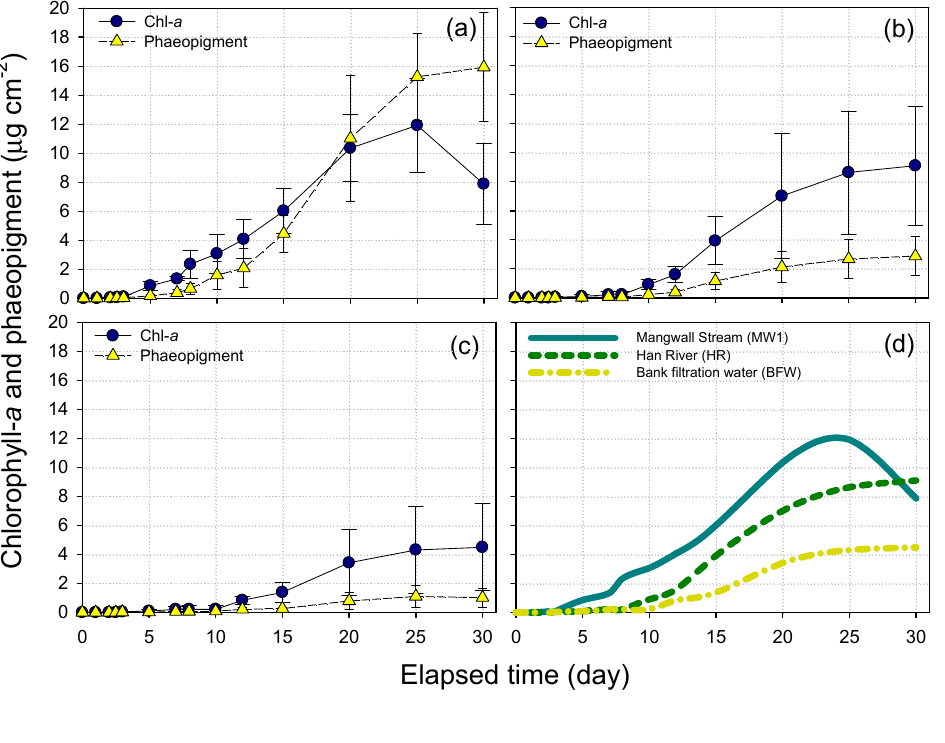
Figure 4 The periphyton biomass accrual curves in terms of chl- a and phaeopigment concentrations for 30 days with different water sources: ( a ) MW1; ( b ) HR; ( c ) BFW; and ( d ) trend lines of chl- a for MW1, HR, and BRW (Experimental conditions: water velocity = 5 − 30 cm s − 1 , type of substratum = tile, concrete, and pebble, and number of observation for each water source =